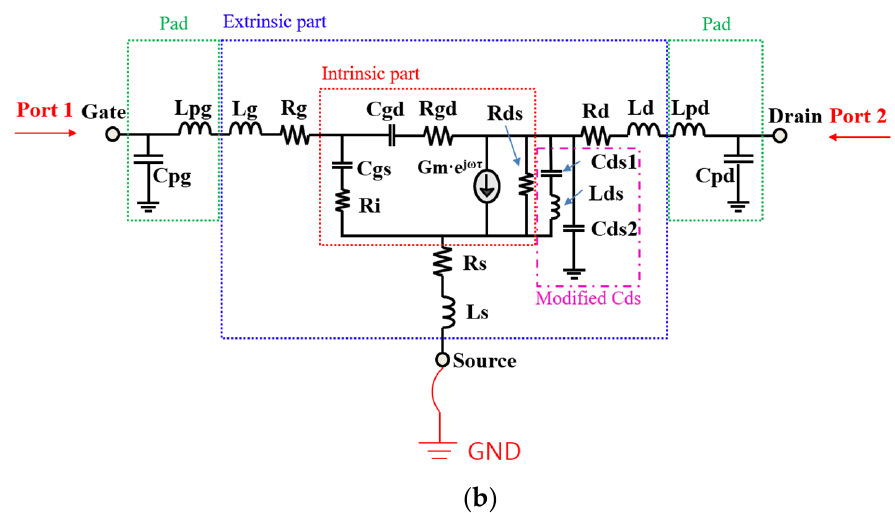
Figure 5. ( a ) Conventional and ( b ) proposed small-signal equivalent circuit of a GaN HEMT.